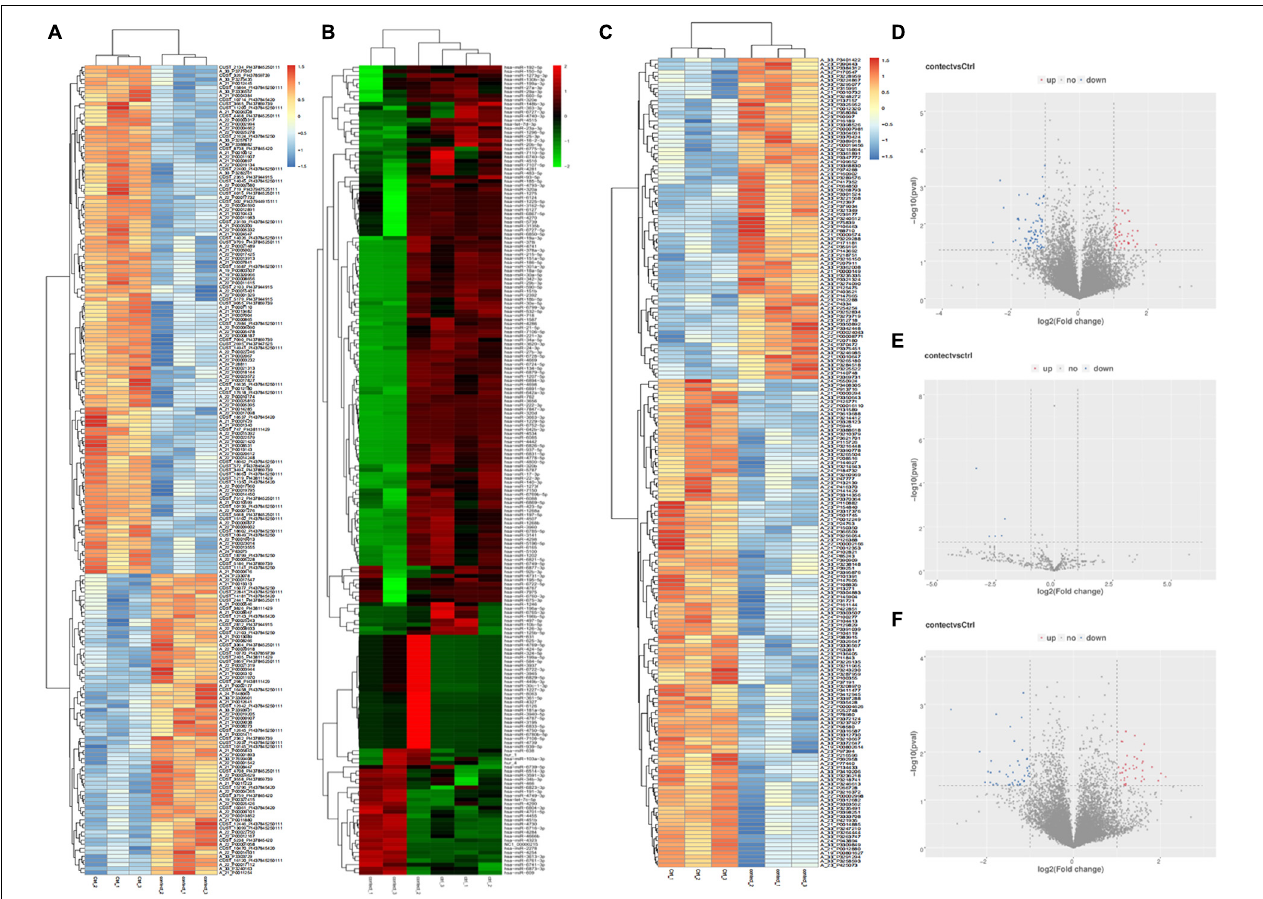
FIGURE 1 | Differentially expressed lncRNAs, miRNAs, mRNAs heat map, volcano map representing the differentially expressed genes from the plasma of patients with rare-earth pneumoconiosis. (A) Differential expression of the lncRNA heat map. (B) Differential expression of the miRNA heat map. (C) Differential expression of the mRNA heat map. (D) Differentially expressed lncRNA volcano map. (E) Differentially expressed miRNA volcano map. (F) Differentially expressed mRNA volcano